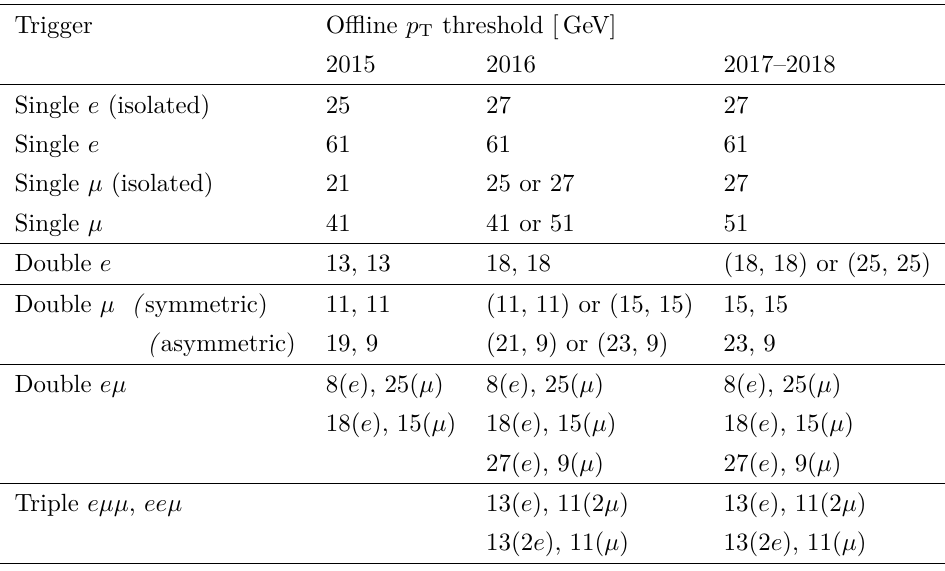
Table 2. The triggers used in the analysis of 2015–2018 data. The offline p T thresholds are required only for reconstructed charged leptons responsible for triggering the event. Trigger thresholds increase across the years due to the increase in beam luminosity, and “or” denotes a move to a higher-threshold trigger during